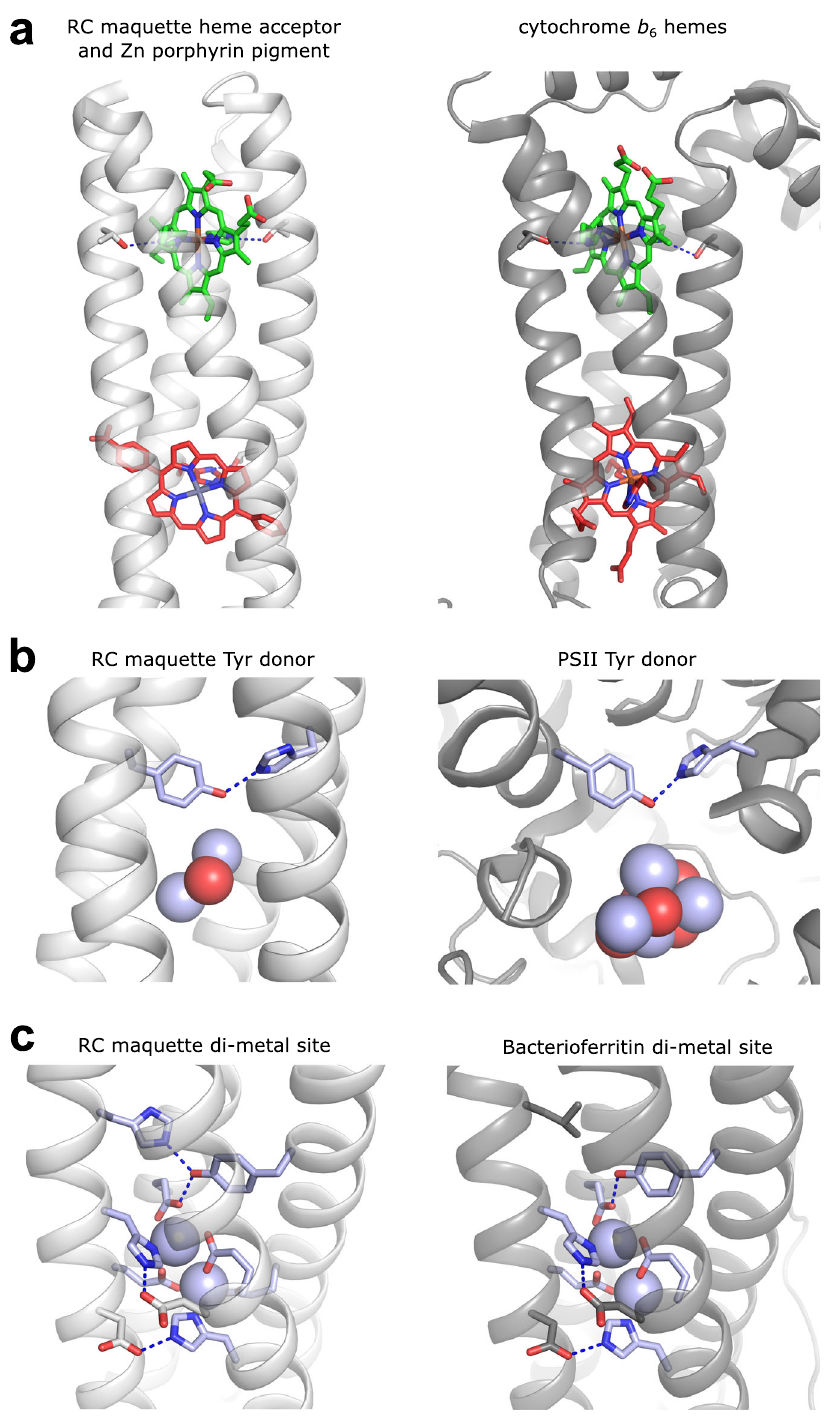
Fig. 2 | Structural similarities between cofactor binding sites of designed RC maquette and natural proteins are signi fi cant despite lack of sequence iden- tity. RC maquette crystal structures are shown in white with heme electron acceptorandligatingHisresiduesshowningreen,ZnPpigmentandHisinred,and electron donating Tyr, metal ion spheres and fi rst shell ligands in blue. Natural protein structures are shown in gray with cofactors colored as in RC maquette.